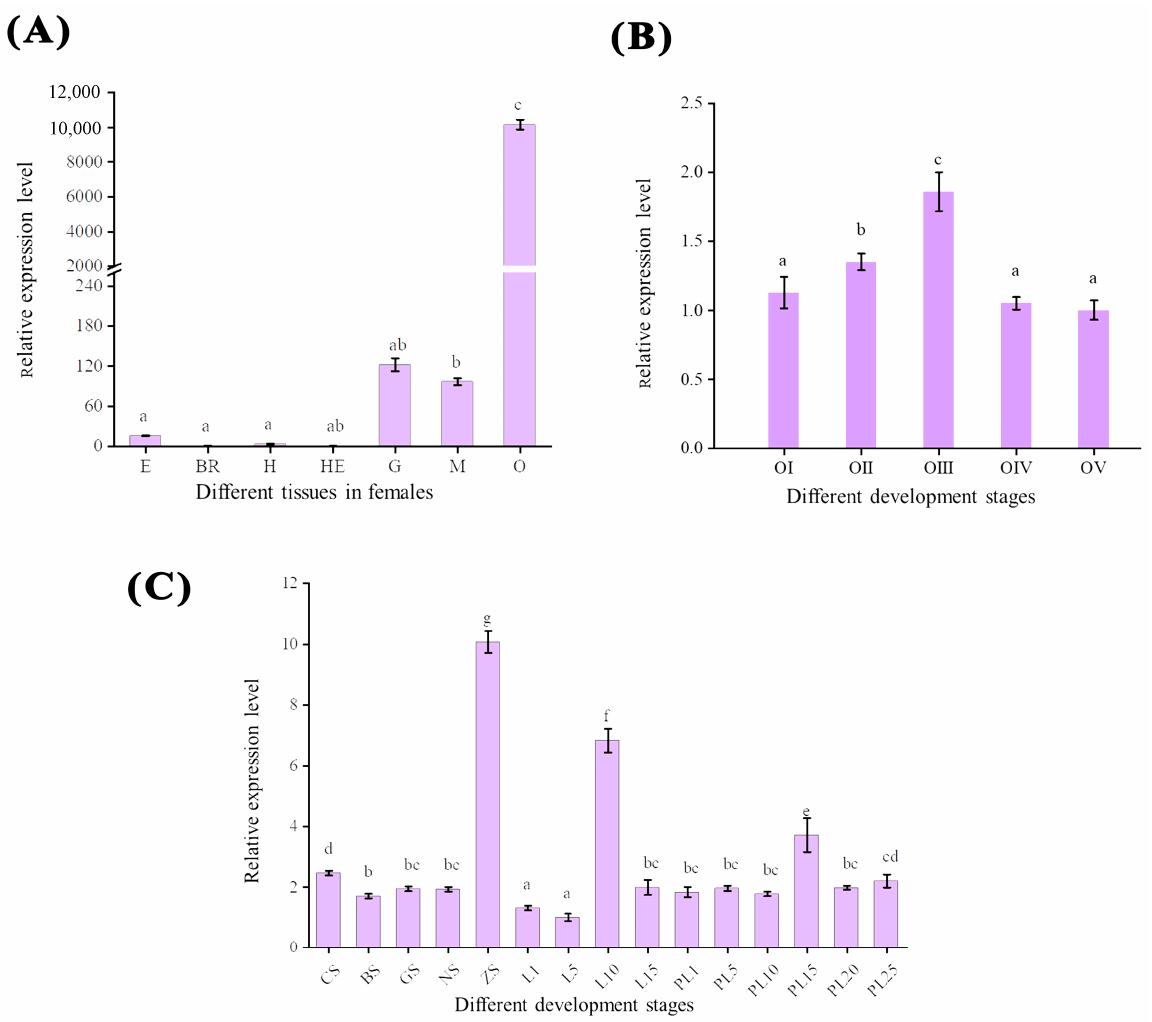
Figure 4. The expression pattern of the Mn-CH7D gene in different tissues ( A ), different stages of ovarian maturation ( B ), and developmental stages ( C ) of Macrobrachium nipponense were measured by qPCR. E: eyestalk, Br: cerebral ganglion, H: heart, He: hepatopancreas, G: gill, M: muscle, O: ovary; Data are presented as the mean ± SD (n = 6). Different letters indicate significant differences. p < 0.05 was considered to be statistically signi fi cant.